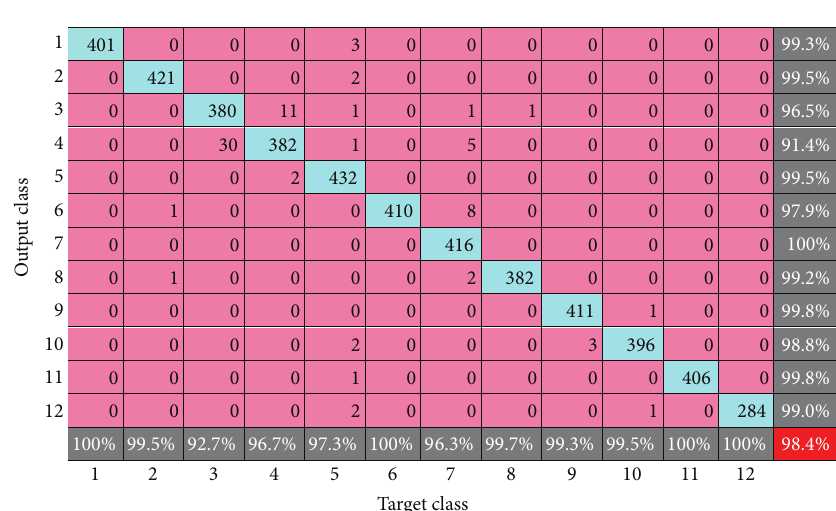
Figure 6: Implementation of classifier based on CNN and statistical features.